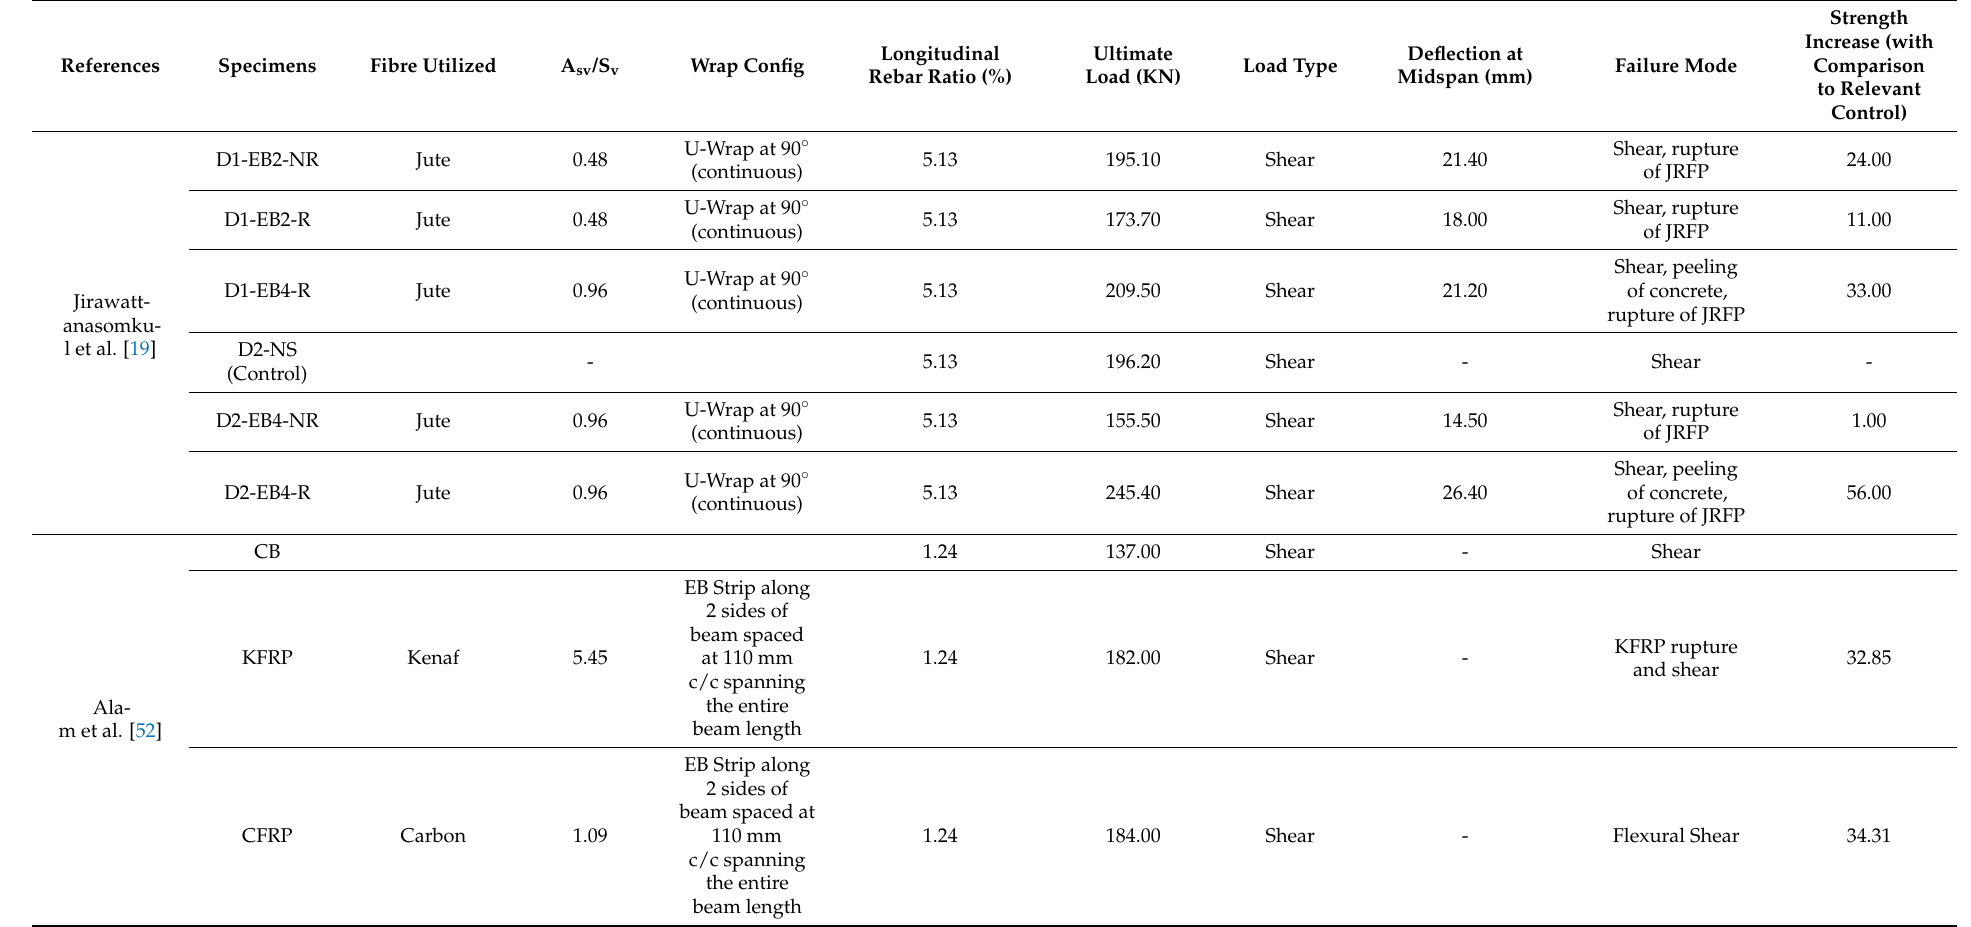
Table 4. Comparison RC beam shear strengthening results using EB natural